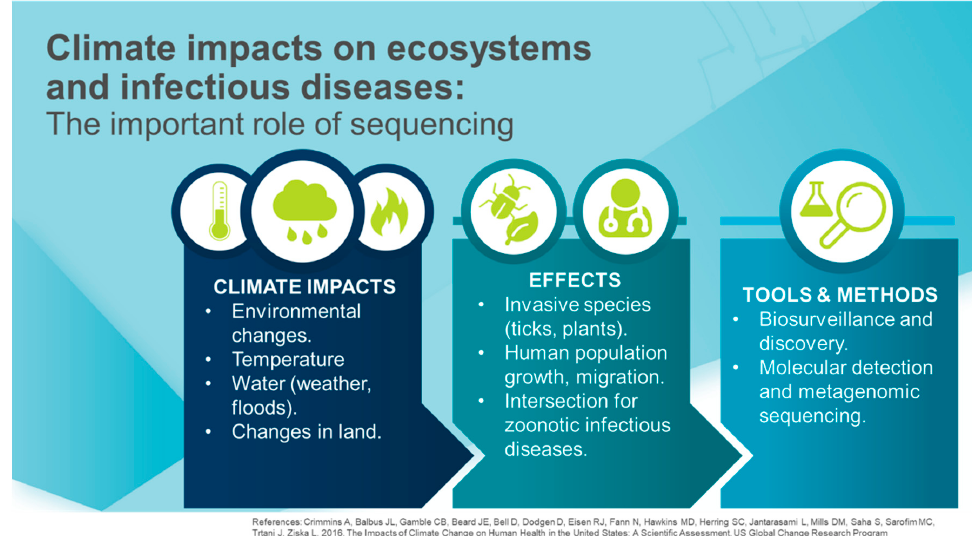
Figure 1. Climate impacts [30] whose effects on ecosystems and infectious diseases can be investigated using a variety of tools.